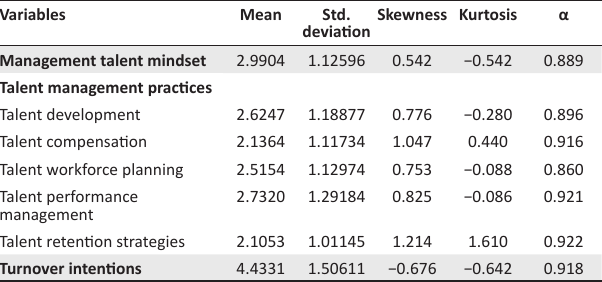
Skewness Kurtosis α deviation